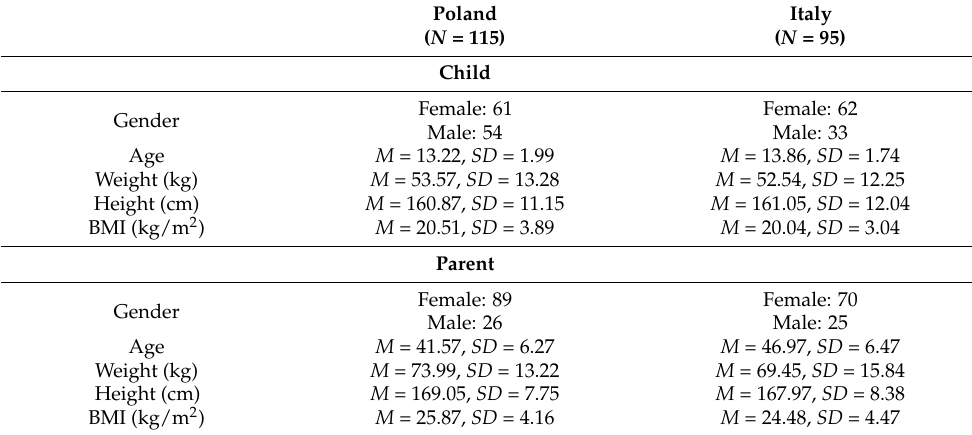
Table 1. Demographic characteristics of parent-child dyads in Poland and